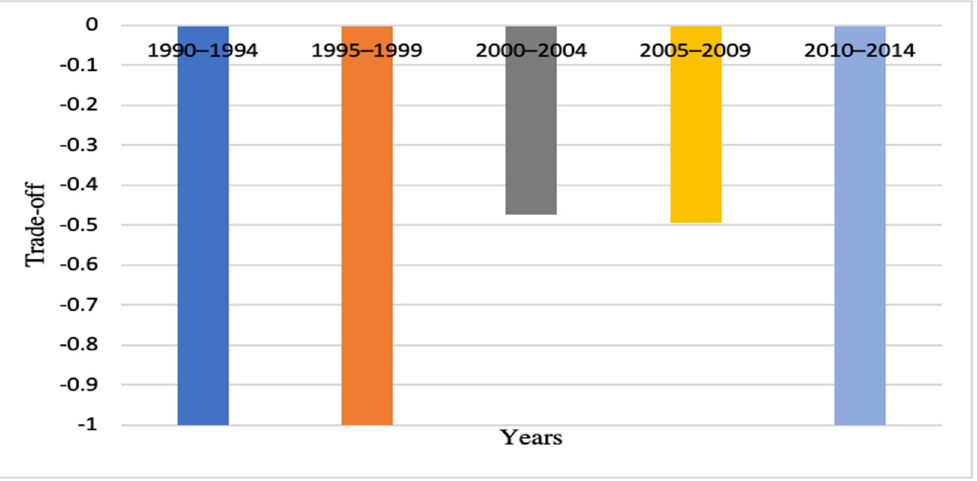
Figure 12. Synergy: GHG emission (CO 2 ) from energy sector (Industrial, Transport and Others) and renewable energy share in total final energy consumption.